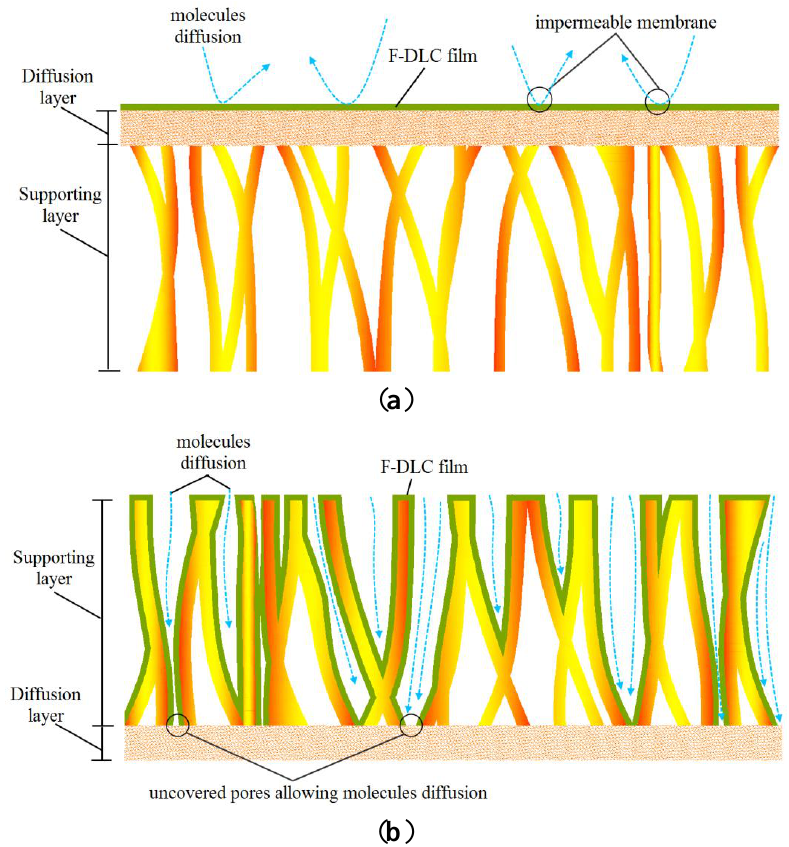
Figure 9. Characteristic of F-DLC film: ( a ) deposited on the diffusion layer; ( b ) deposited on the finger like structure